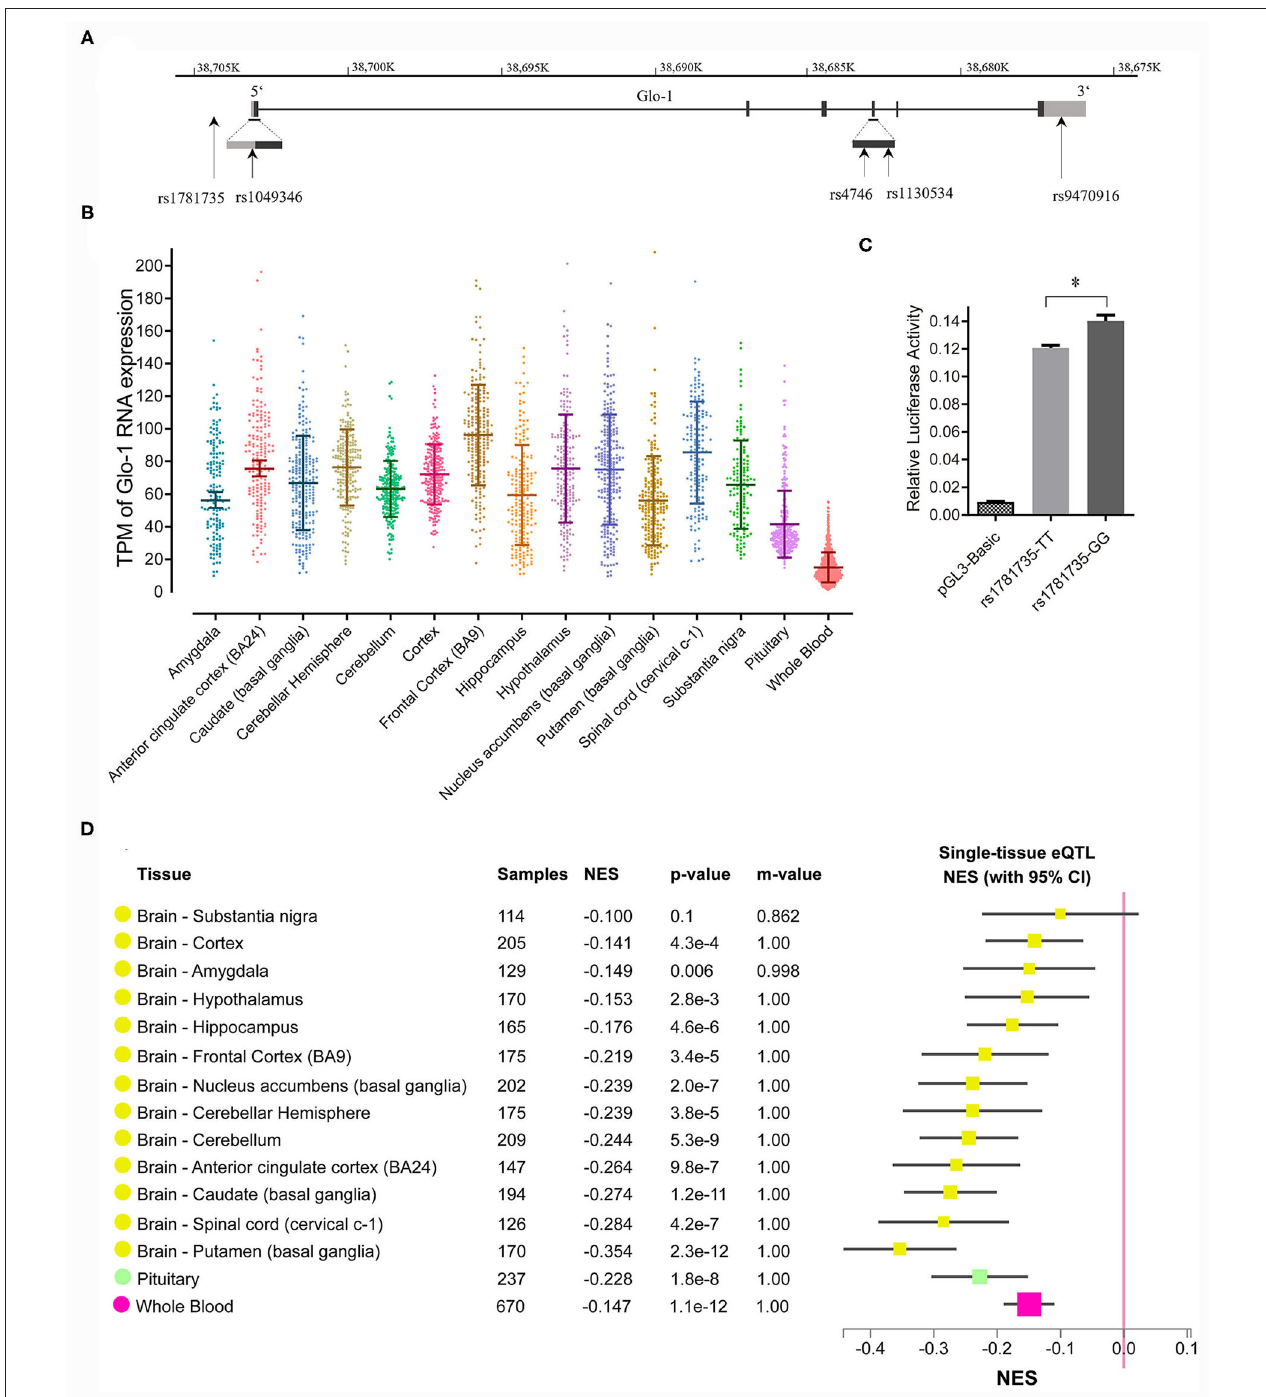
FIGURE 1 | (A) Distribution of single nucleotide polymorphisms (SNPs) across the Glo-1 gene selected for the association analysis. Exons are shown as black boxes (exons), and intron sequences are shown as lines. The gray boxes represent the 3’ untranslated region (3’-UTR) and 5’ untranslated region (5’-UTR). The vertical lines indicate the locations of these polymorphisms. Five SNPs were identified in the Glo-1 gene from the HapMap/Haploview database and the literature; (B) transcripts per kilobase million (TPM) values of the Glo-1 expression pattern in the brain tissues and whole blood in healthy participants. (C) Effect of the rs1781735 T/G polymorphism on the transcriptional activity of the Glo-1 promoter. *, P < 0.05. The error bar in the bar plot represents the SD of the mean. (D) GTEx Multitissue expression quantitative trait locus (eQTL) Plot for rs1781735. NES, normalized effect size. P -value, from a t -test that compares the observed NES from single-tissue eQTL analysis to a null NES of 0; m-value, the posterior probability that an eQTL effect exists in each tissue tested in the cross-tissue meta-analysis. Small m-value (e.g., < 0.1): the study is predicted to not have an effect. Large m-value (e.g., > 0.9): the study is predicted to have an effect.